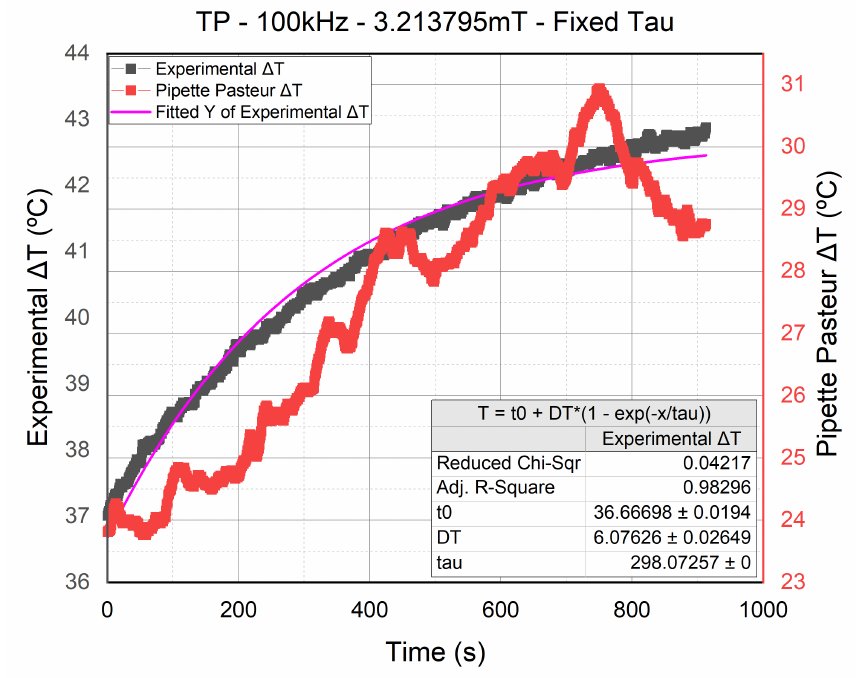
Figure 12. Repeating the fitting of Figure 7 while fixing τ T equal to the calibration result value. Using Equation (6), we were able to establish a ratio determining the unconventional waveform’s efficiency compared to the conventional sinusoidal, where a negative and a positive ∆ P ∗ refer to a lesser and higher efficiency, respectively. Furthermore, the SAR i , j value was calculated based on the Box - Lucas method described in Wildeboer et al. [31], using the τ T deduced from the cast - out approach described previously. However, the thermal capacitance ( C T ) was taken from the calibration results in Rosales et al. [27], although the value is probably inaccurate since the τ T acquired from the same calibration was also unreliable. However, similar to the ∆ P ∗ , we merely aim to analyze and compare i , j the SAR values of each signal. The results are represented in Table